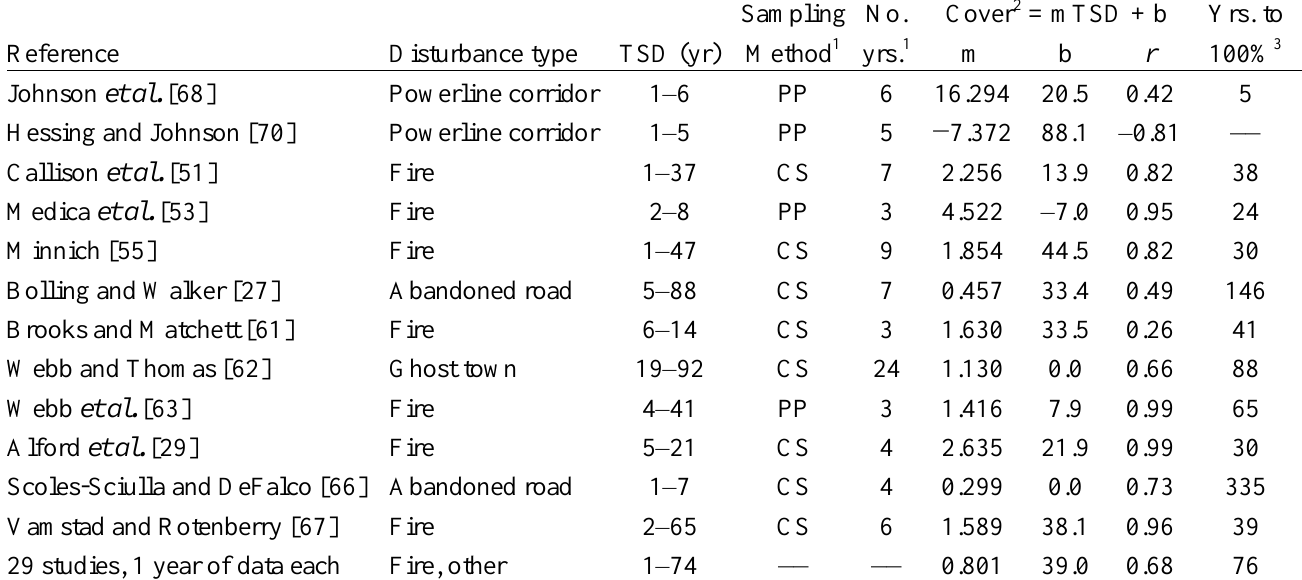
Table 1. Relationship of time since disturbance (TSD) and perennial plant cover in the Mojave and Sonoran Deserts of the American Southwest.